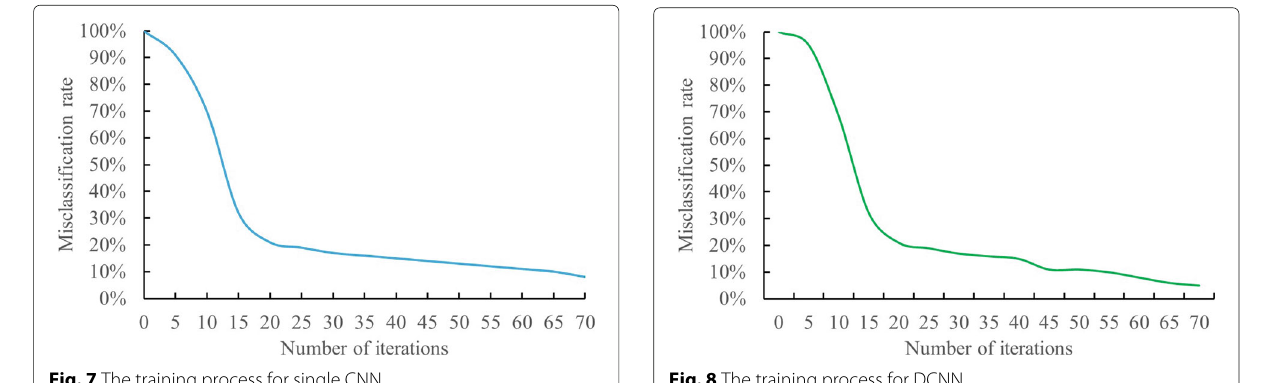
feature extraction using the single CNN and DC-CNN are classified and compared. In the test, the numbers of images of insulators, transformers, breakers, transmission line poles and towers are 3000, 2000, 2000, 3000 and 500, respectively. Among them, 2000 insulator images, 1500 transformer images, 2000 circuit breaker images, 1000 transmission line pole images and 300 tower images were selected as training samples, and the rest were taken as test